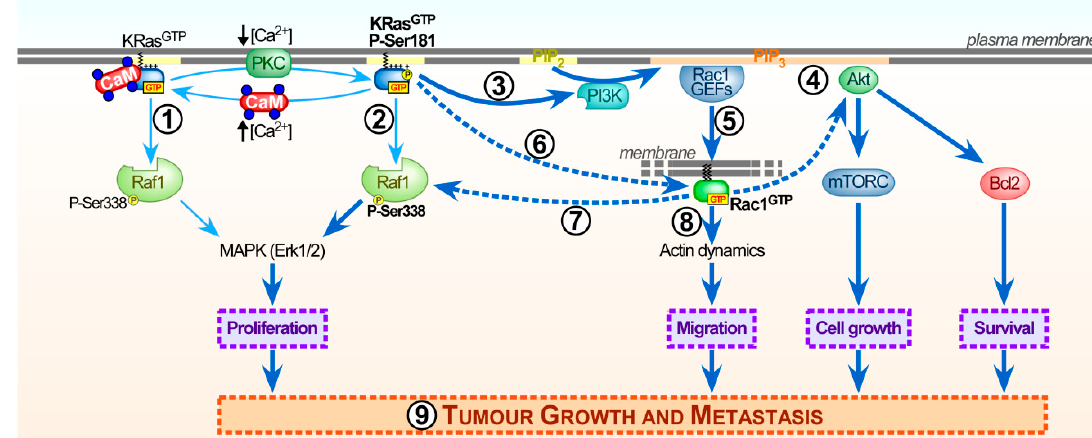
Figure 3. Model of calmodulin and protein kinase C (PKC) modulating critical features of KRas-driven tumourigenesis . This hypothetical model is based on studies comparing the impact of pharmacological compounds modulating PKC or calmodulin activity in a variety of cell models expressing wild-type or oncogenic and constitutively active KRas (KRasG12V) containing Ser181-phosphomimetic or non-phosphorylatable mutants (see Section 3.4.3 for further details) [16,29,105,121,169,170]. ( 1 ) Ca 2 +/ calmodulin binding to the polybasic region (PBR) within the hypervariable region (HVR) of KRas inhibits PKC-mediated Ser181 phosphorylation of KRas (P-Ser181) by sterical hindrance. Complex formation of calmodulin with (active) KRas-GTP may segregate KRas to membrane microdomains where KRas-GTP could be more susceptible to GTPase activating protein (GAP)-mediated KRas inactivation. This ensures KRas inactivation and termination of KRas-GTP-mediated activation of phosphoinositide 3-kinase (PI3K) e ff ector pathways. ( 2 ) Low Ca 2 + levels disrupt KRas / calmodulin interaction and favor PKC-mediated Ser181 phosphorylation of KRas. ( 3 ) This allows a conformational change in P-Ser181 KRas and is followed by its segregation to distinct plasma membrane microdomains or endosomal membranes (omitted in this scheme), where interaction and activation of e ff ectors like PI3K can occur. ( 4 ) Ser181 phosphorylation of oncogenic KRas (KRasG12V) triggers PI3K and Akt-dependent anti-apoptotic signals driven by B-cell lymphoma 2 (bcl2) and mammalian target of rapamycin complex (mTORC) that promote survival and cell growth, respectively. ( 5 ) PI3K also activates Rac1 guanine nucleotide exchange factors (Rac1 GEFs) that promote activation of Rac1 (Rac1-GTP) on plasma (or endosomal) membranes (dashed lines). The membrane location of phosphatidyl-4,5-biphosphate (PIP2) and phospharidylinositol-3,4,5-triphosphate (PIP3) is indicated. ( 6 ) Alternatively, active KRas (KRas-GTP) can directly associate with a Rac1-GEF to activate Rac1. ( 7 ) Vice versa, active Rac1-GTP and its e ff ector Pak1 have been suggested to facilitate Ser338 Raf1 phosphorylation and activation, which a ff ects proliferation along the Raf1 / mitogen-activated protein kinase (MAPK) pathway. ( 8 ) Rac1-GTP drives actin dynamics linked to cell migration. ( 9 ) These complex regulatory networks are highlighted by the requirement of Rac1 activity in KRas-driven cancers (see Section 5 for further details). Overall, Ser181 phosphorylation of oncogenic KRas is at the forefront of multiple signalling pathways that are fundamental to cellular events that drive tumour growth and metastasis. This can be counteracted by KRas / calmodulin complex formation, providing a potential tool to reduce signal output of oncogenic